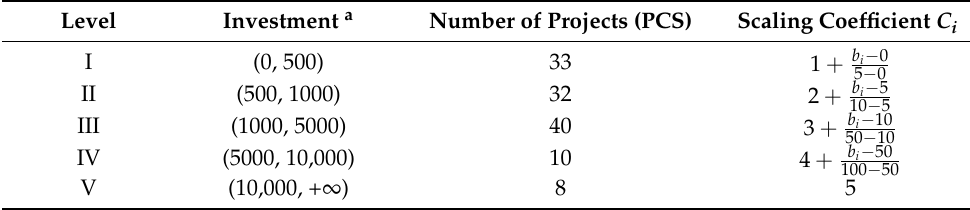
Table 1. Five levels of scaling coefficients.